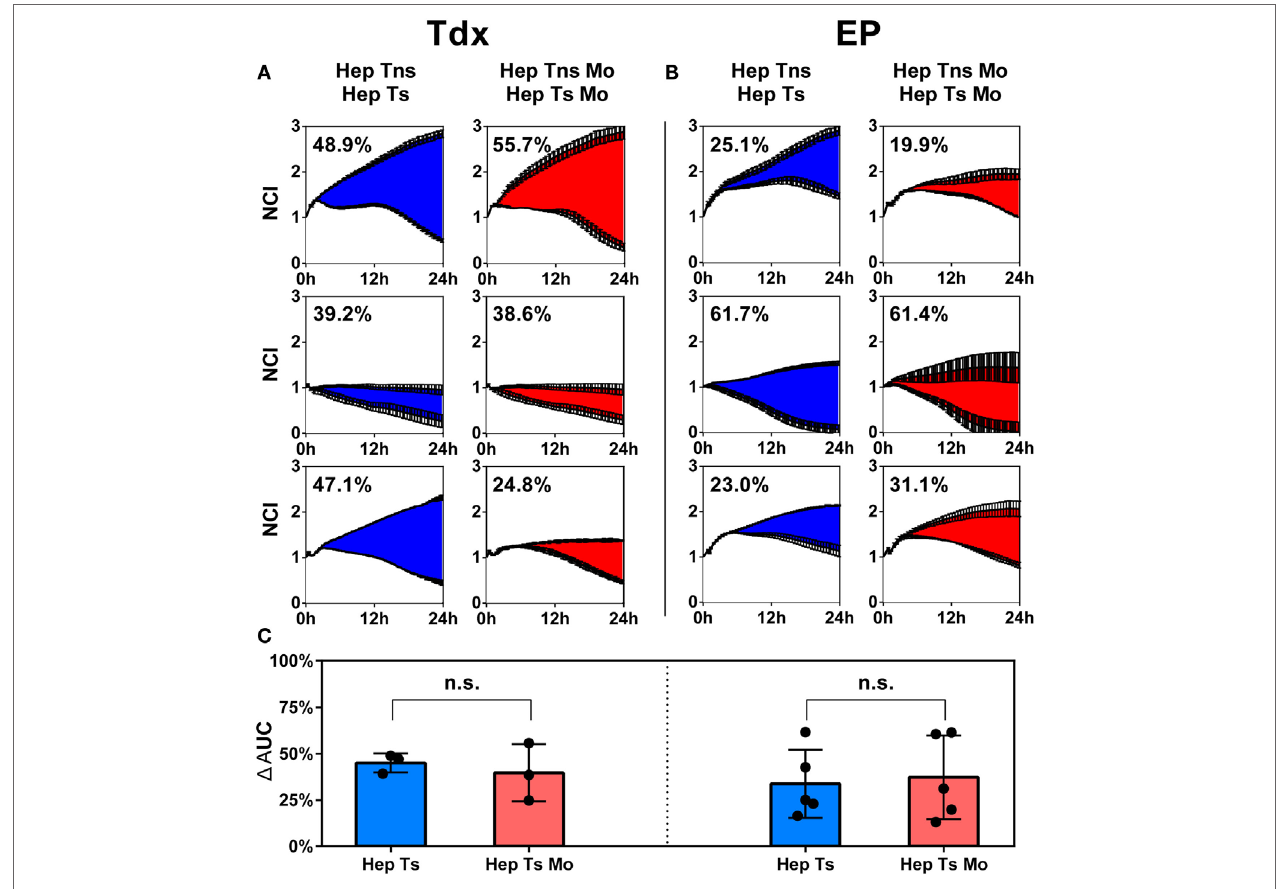
FigUre 4 | (a,B) Results from the impedance assay plotted as growth of the target cells over time for up to 24 h, measured as a NCI for Tns (top lines) and Tdx (a) or EP (B) HBV-specific TCR T cells (bottom lines). Each row represents a different donor. The numbers in each plot indicate the percentage difference of the AUC of target cell killing in HepG2-T cells co-cultures either in the absence (blue) or presence (red) of monocytes. Every curve is the average of at least two measurements for each condition and at least three experiments were performed. (c) Bar plots representing the average of all differential AUC measured in the experiments for Tdx (left panel) and EP (right panel) HBV-specific TCR T cells. Statistical significance was evaluated by a two-tailed t -test, with P < 0.05 taken as evidence of statistical significance. AUC, area under the curve; EP, mRNA-electroporated; HBV, hepatitis B virus; Hep, HepG2.2.15; Mo, monocyte; NCI, normalized cell index; n.s., not significant; TCR T cells, T cell receptor-redirected T cells; Tdx, transduced; Tns, non-specific T cells; Ts, HBV-specific T